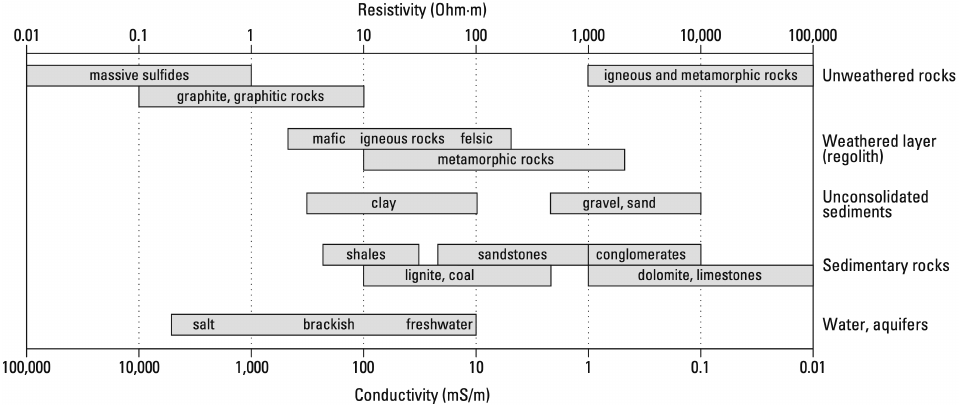
Figure 7. Resistivity values of various rock types and materials, from Palacky